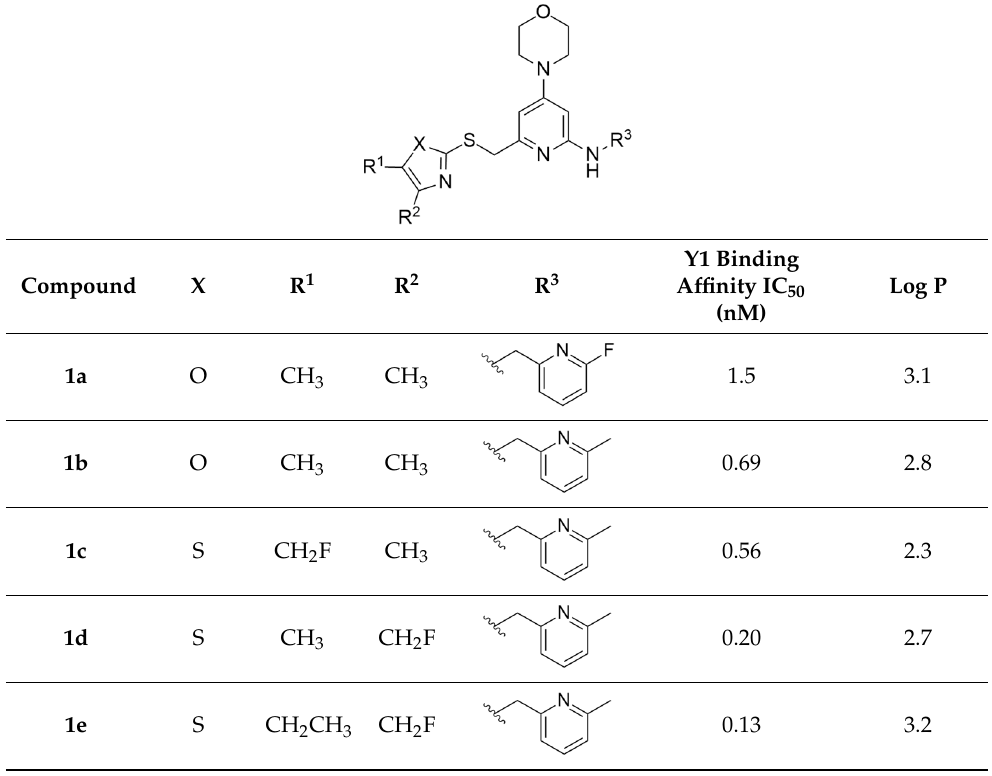
Table 3. SAR of compounds 1a – e . Table 3 . SAR of compounds 1a – e . Table 3 . SAR of compounds 1a – e . Table 3 . SAR of compounds 1a – e . Table 3 . SAR of compounds 1a – e .